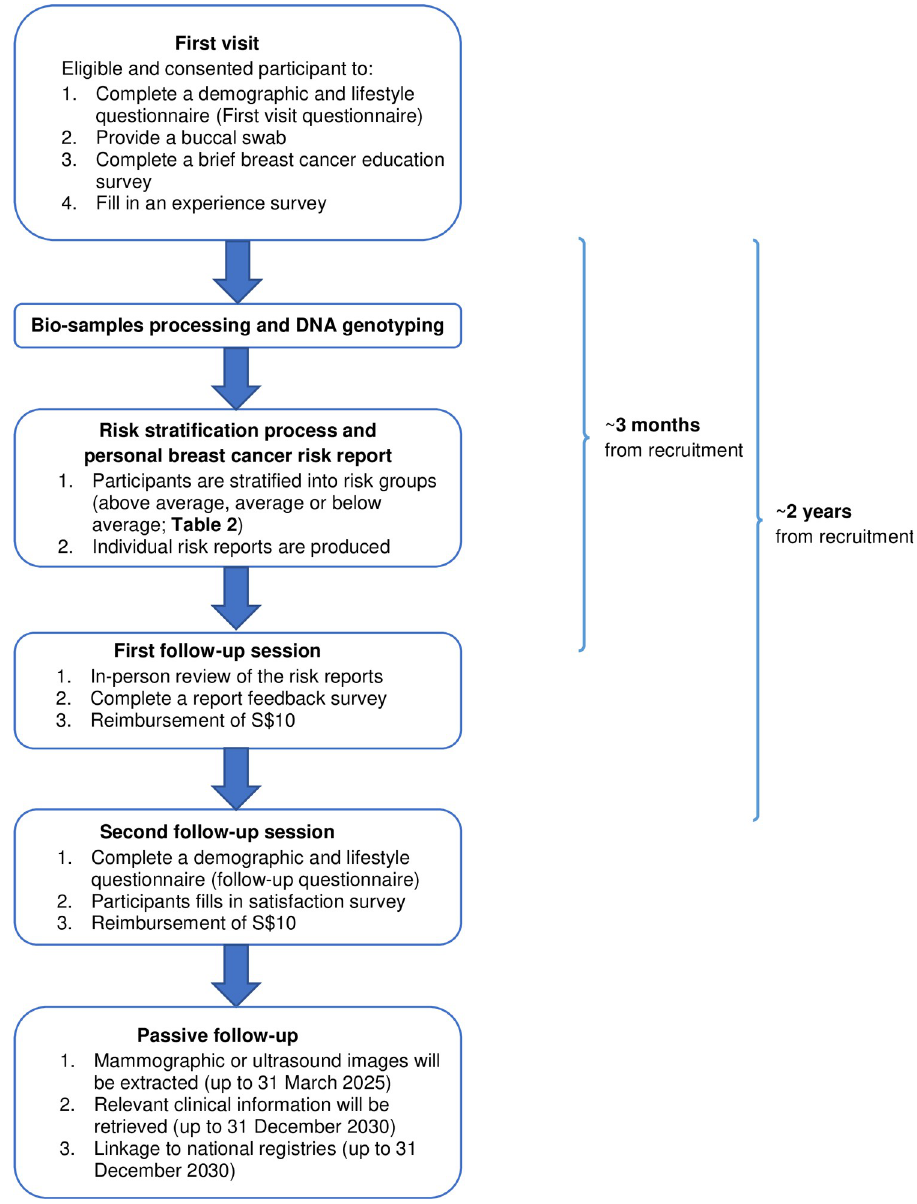
Fig 1. Summary of the recruitment and follow-up process. This study was approved by the National Healthcare Group Domain Specific Review. Board (reference no: 2020/01327). Written informed consent will be obtained from each